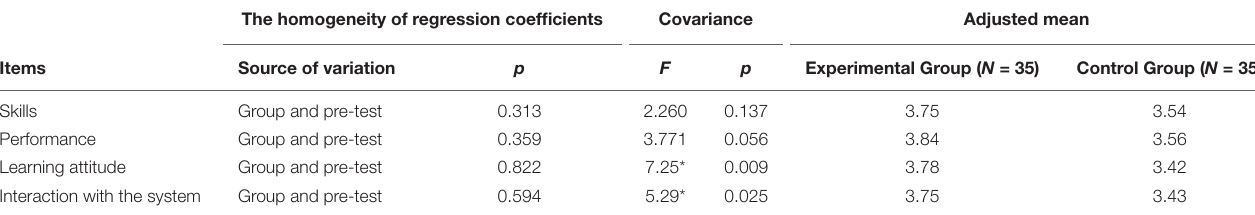
TABLE 2 | Learning engagement of homogeneity of regression coefficients and the analysis of covariance.